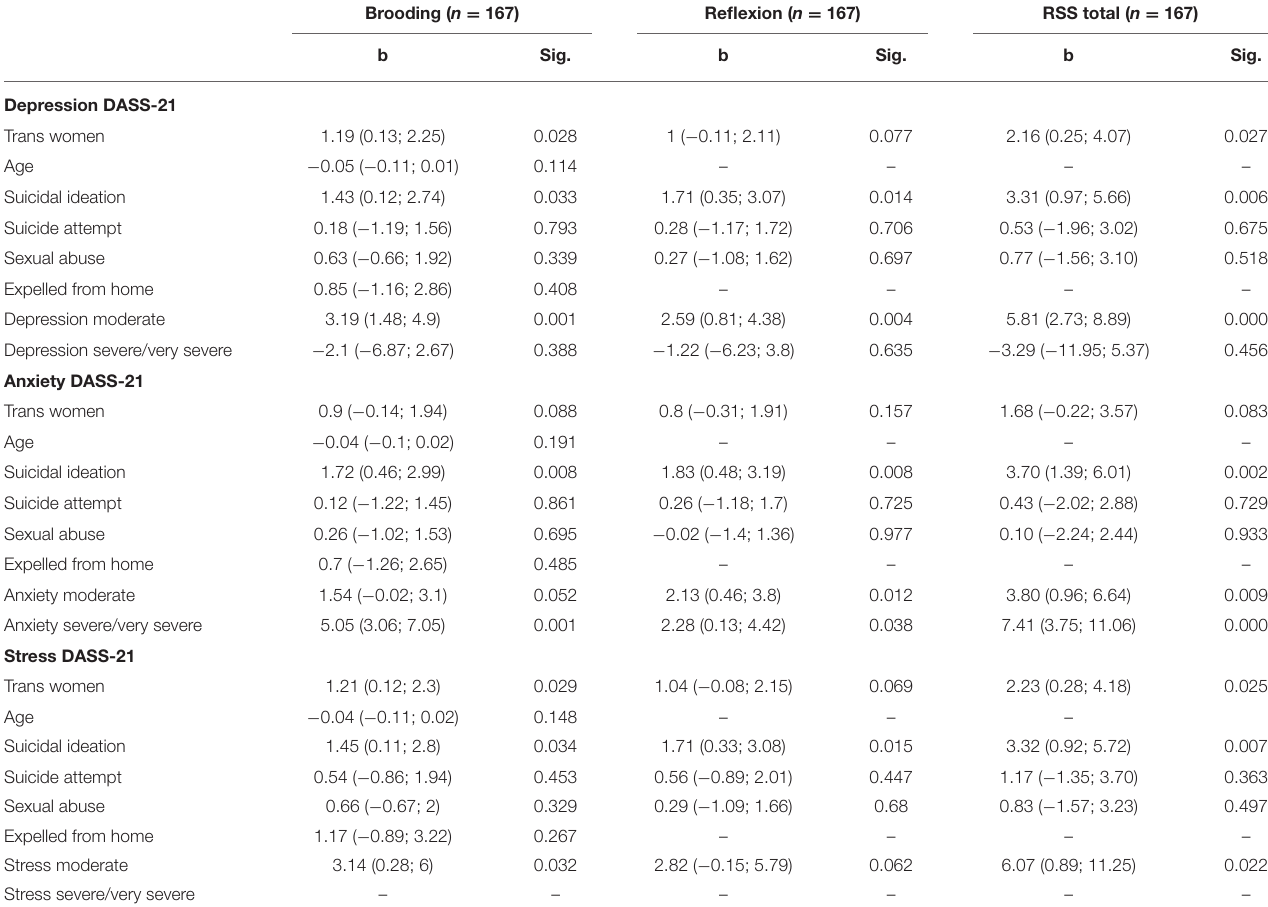
TABLE 3 | Multivariate model associated with brooding and reflexion ( n = 167). Brooding ( n = 167) Reflexion ( n = 167) RSS total ( n = 167) b Sig. b Sig. b